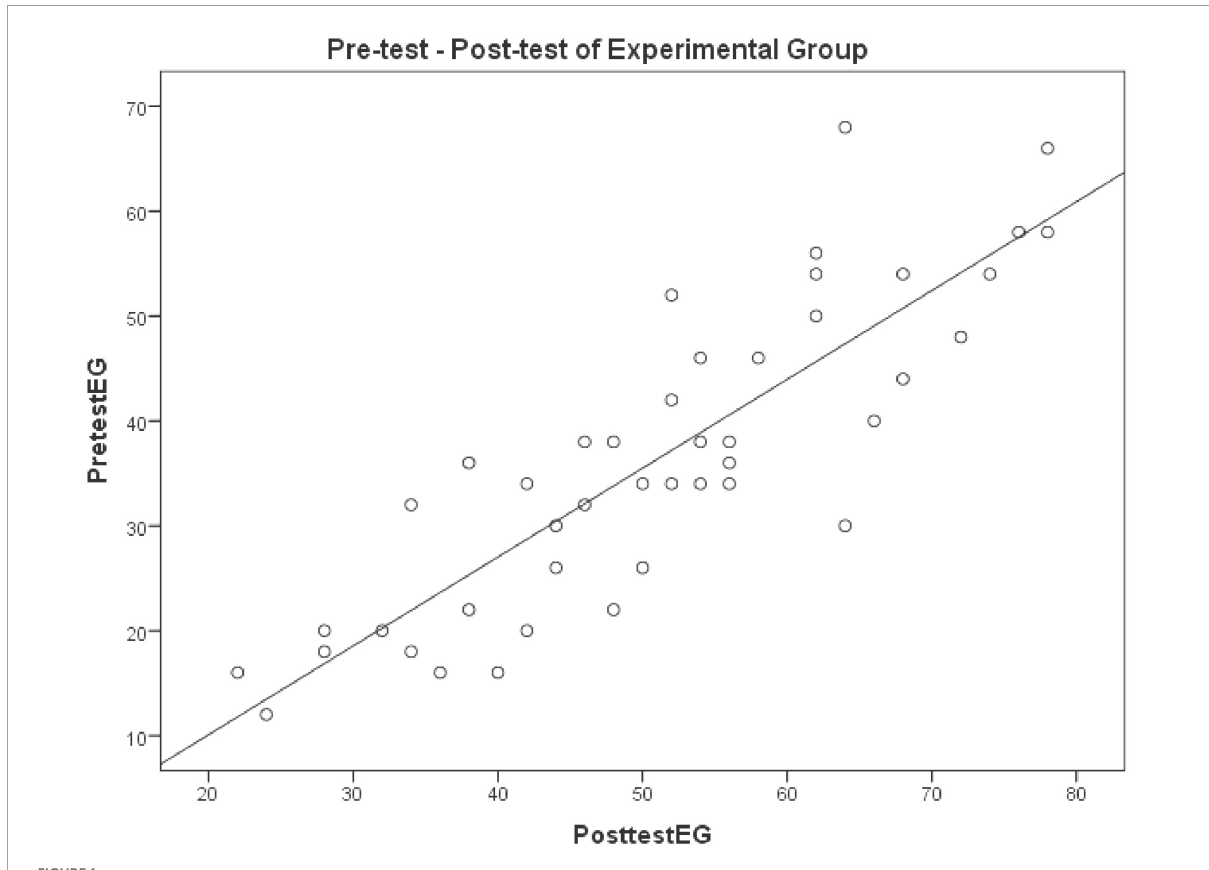
FIGURE1 Scatter chart of experimental group